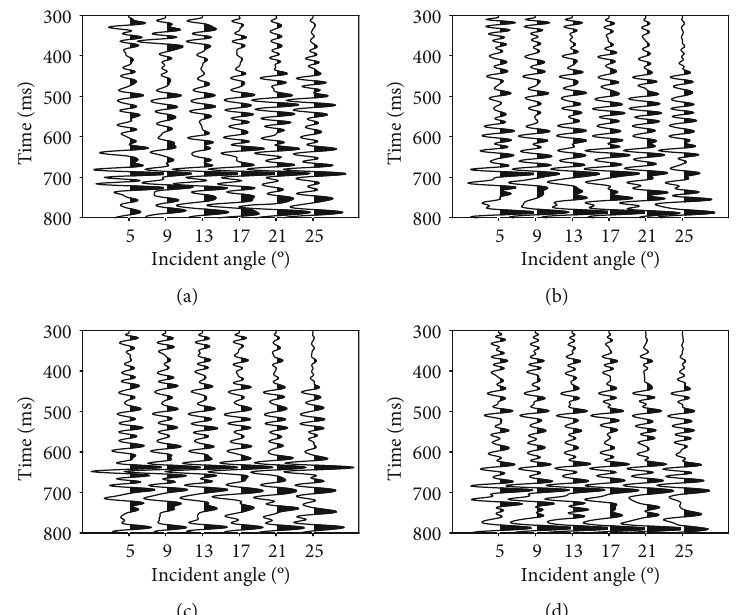
Figure 9: The angle gathers with incident angles ranging from 5 ° to 25 ° at (a) CDP 176, (b) CDP 528, (c) CDP 880, and (d) CDP 1232.